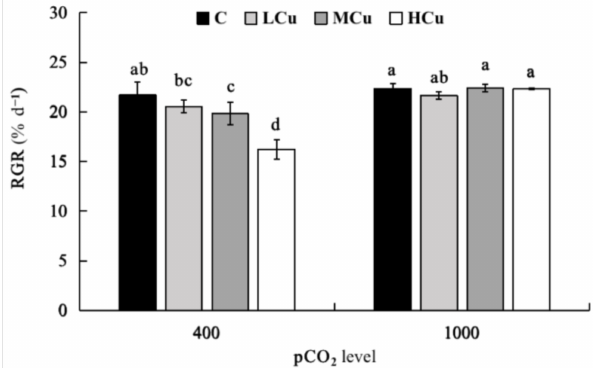
Figure 1. Relative growth rates of S. japonica grown under different pCO 2 levels and copper concen- trations. C (control, natural seawater); Lcu (low copper concentration, 0.2 µ M); Mcu (medium copper concentration, 0.5 µ M); Hcu (high copper concentration, 0.2 µ M). All results are shown as mean value ± SD ( n = 3). Different letters indicate statistical differences ( p < 0.05) among experimental